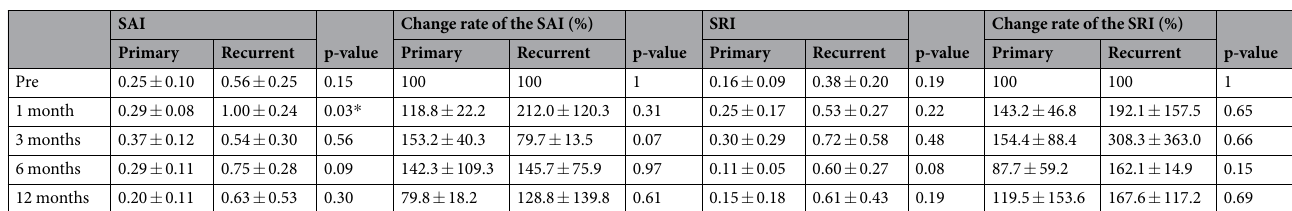
Table 2. Surface asymmetry index (SAI), surface regularity index (SRI), and change rate of the SAI and